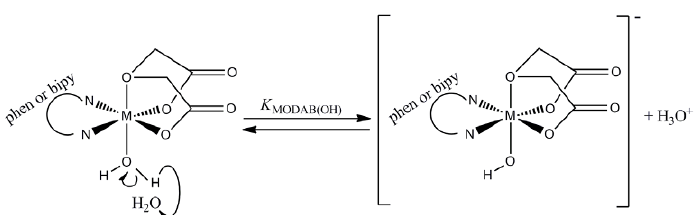
Scheme 2. Hydrolysis of the ternary